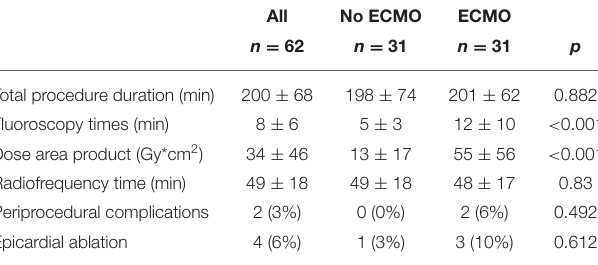
TABLE 2 | Procedural data by thre study